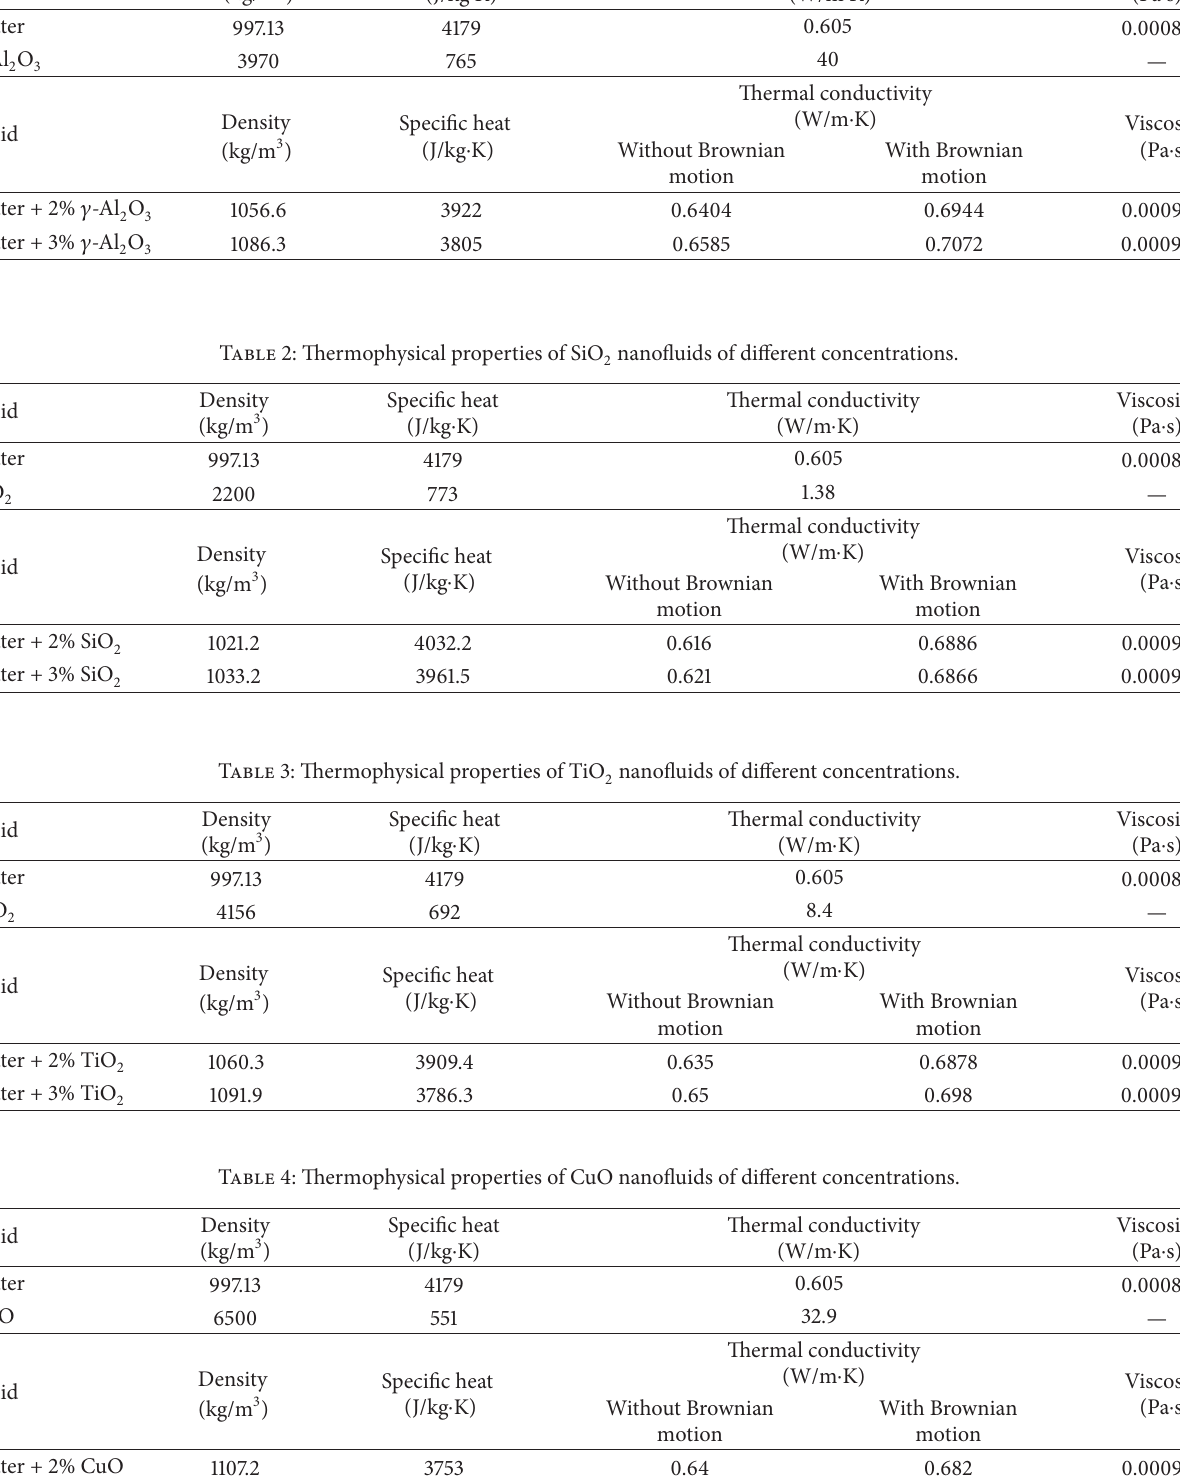
Table 1: Thermophysical properties of Al